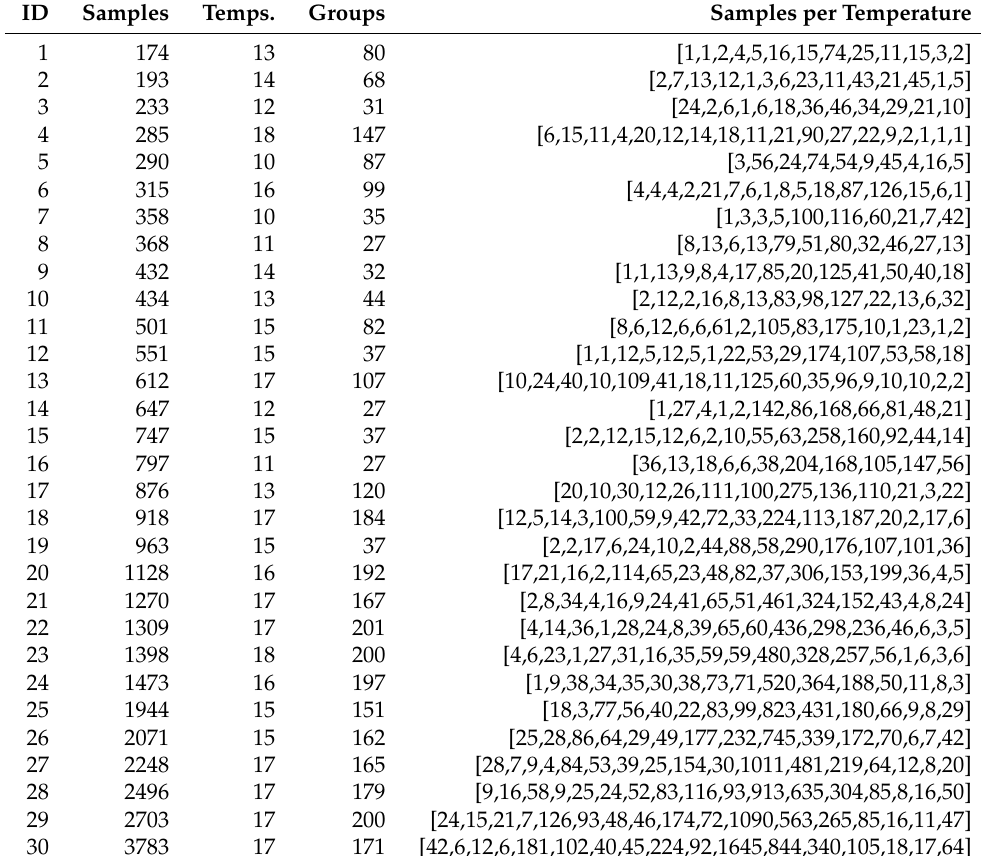
Table A1. Daily available files detailed.